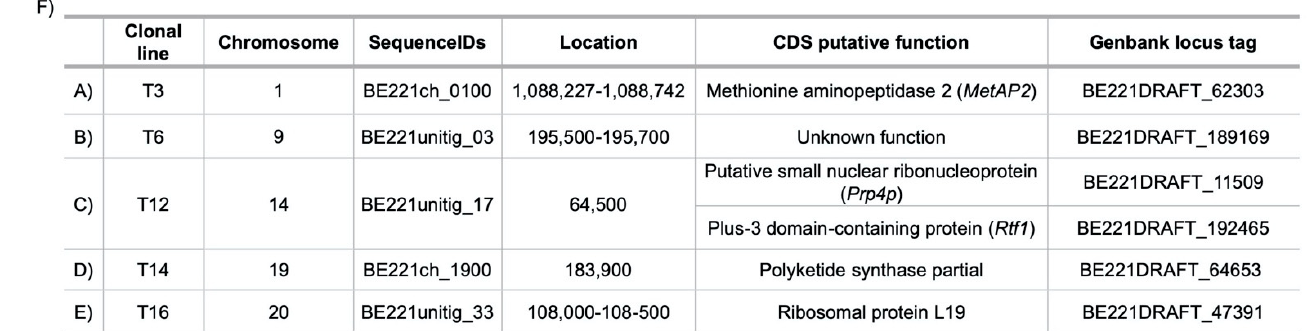
Figure 3. IGV (Integrative Genomics Viewer) visualization of read coverage and identification of insertion sites. Genomic maps of the vector-insertion site in ( A ) T3, ( B ) T6, ( C ) T12, ( D ) T14 and ( E ) T16 transformed clonal lines. The coverage plot is shown in the top panel ( Y -axis the coverage (X) scale), the locations of insertion sites are shown with red arrows and the gene annotation of the reference genome is shown in the bottom panel. ( F ) Exact location of the sites of vector integration and putative functions of genes surrounding the insertion site.